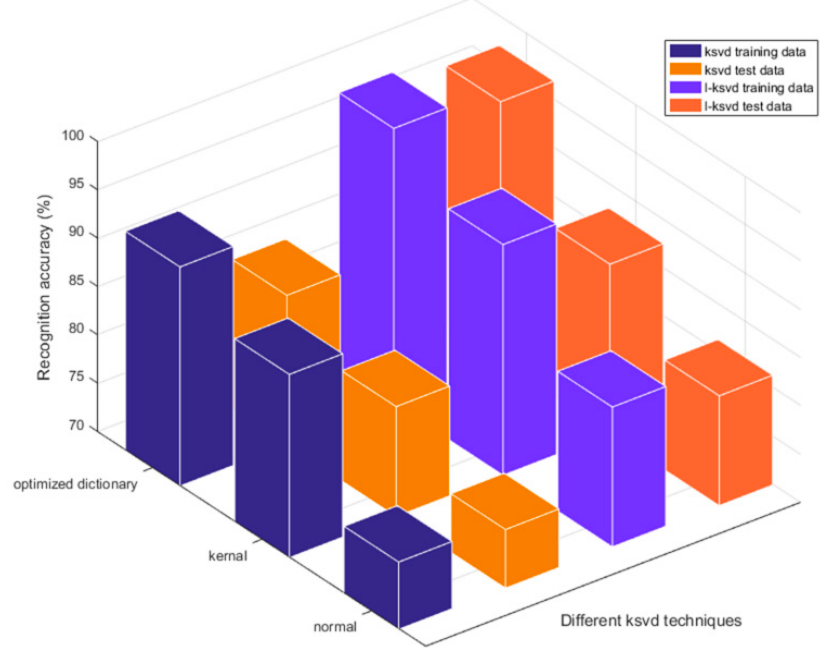
Figure 6. The classification accuracy of different KSVD techniques.